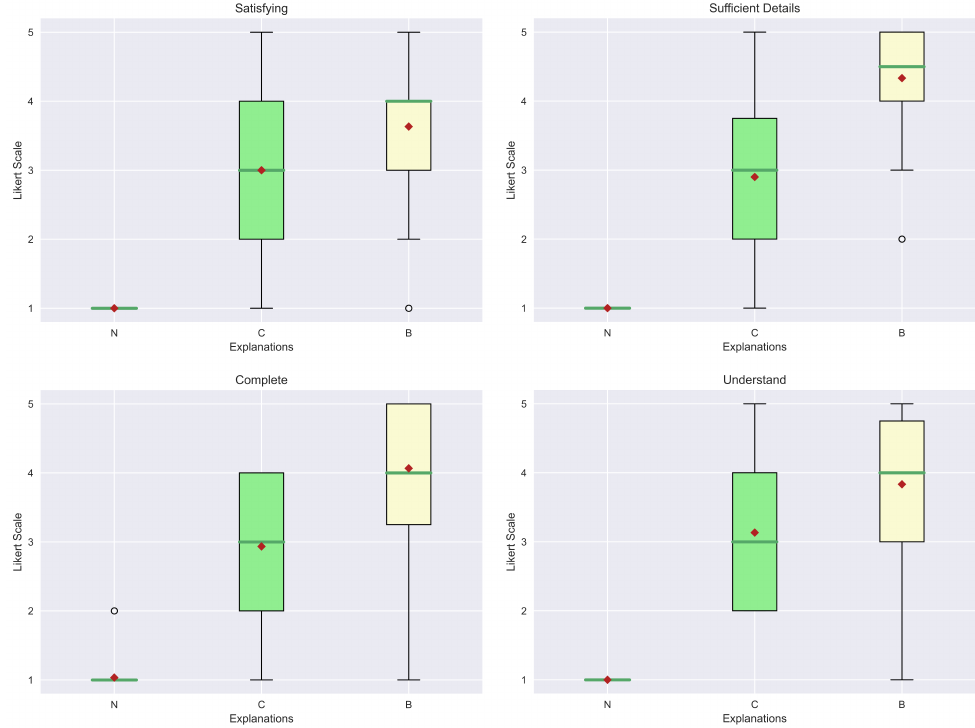
Figure 22. Box plot of the general qualities of the explanations for the “Why Not” question.